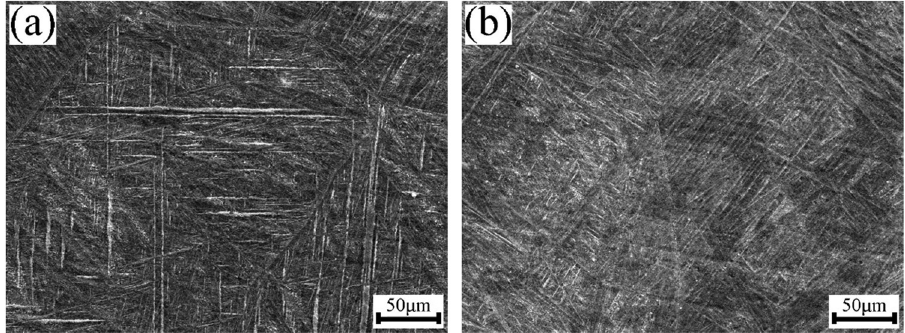
Figure 8: SEM image of α ′ martensite in FZ: ( a ) EBW joint and ( b ) P - LBW joint.